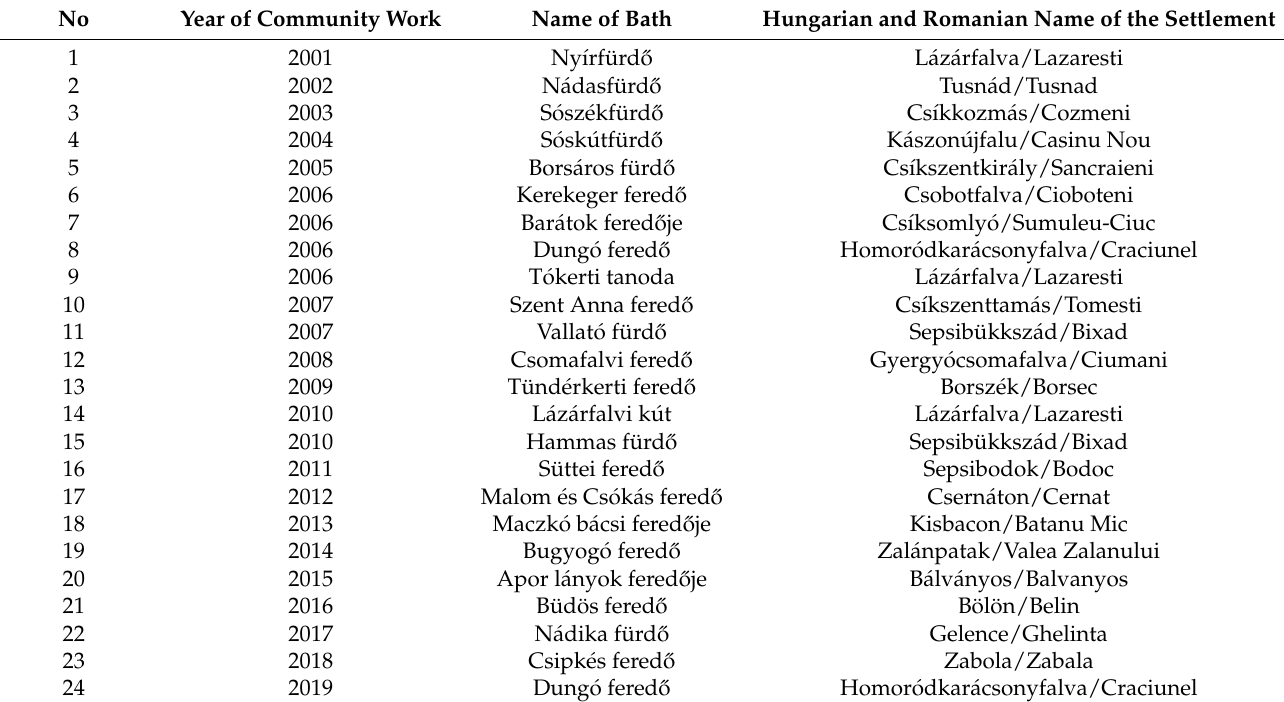
Table 1. List of the bath-building volunteer camps in Szeklerland, in chronological order. The table shows certain sites repeated. Several rehabilitation landscape interventions for restoration purposes have been carried out on these sites over a number of